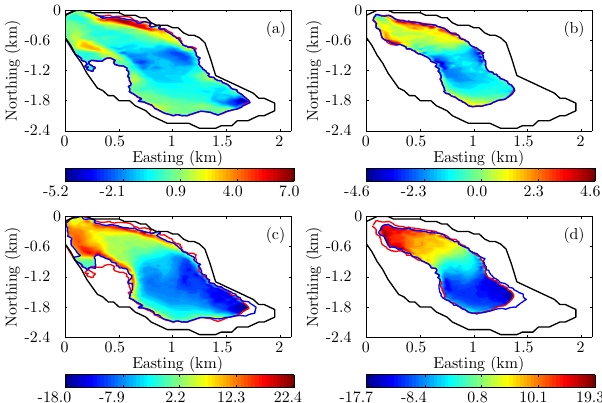
Fig. 13. Differences in ice thickness (m) between the employed models. FS minus PS solutions at (a) 2025 and (b) 2050. FS mi- nus SD solutions at (c) 2025 and (d) 2050. The present-day glacier outline (black line), and future outlines obtained from FS (red) and reduced models (blue) are also shown. Notice that, for better read- ability, we use different color scales in each subplot.